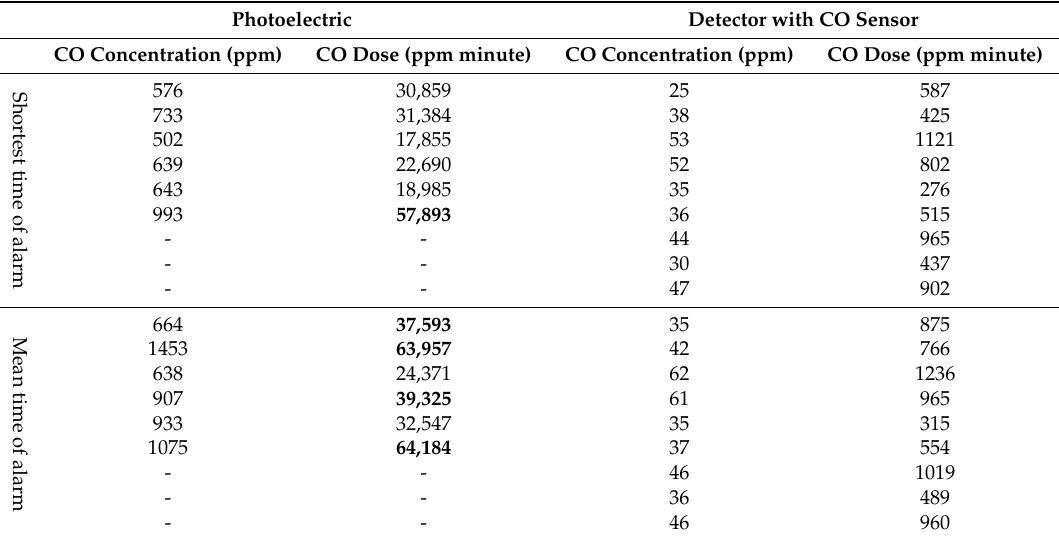
Table 2. Measured CO concentration and CO dose (accumulated since test start) at shortest time of alarm (top) and at mean time of alarm (bottom). Values in bold are above the ID 50 limit. The photoelectric smoke detector did not trigger the alarm for three of the performed fire measurements. CO concentration is consistently higher at the time of activated alarm for photoelectric smoke detector, reaching values above the ID 50 limit. Data extracted from SP Fire Research Experiment Norway